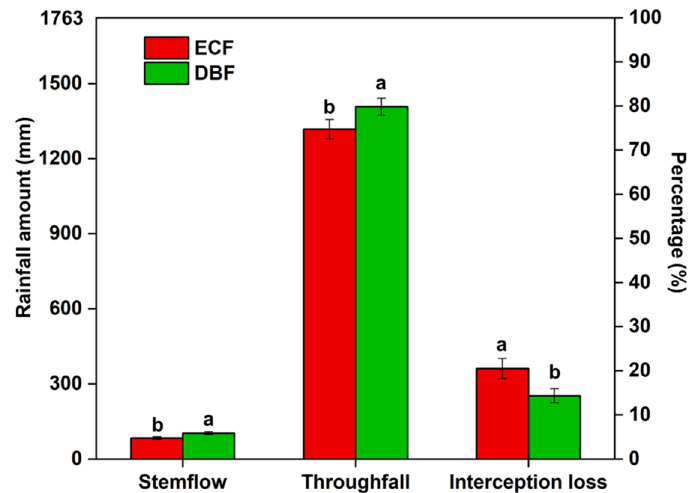
Figure 3. Annual amounts and percentages in rainfall partitions in the ECF and DBF stands in 2015. The vertical error bars are standard deviations; different small letters indicate significant differences in annual amount in rainfall partitioning between the ECF stand and the DBF stand at the 0.05 level. ECF: evergreen coniferous forest; DBF: deciduous broadleaved forest.